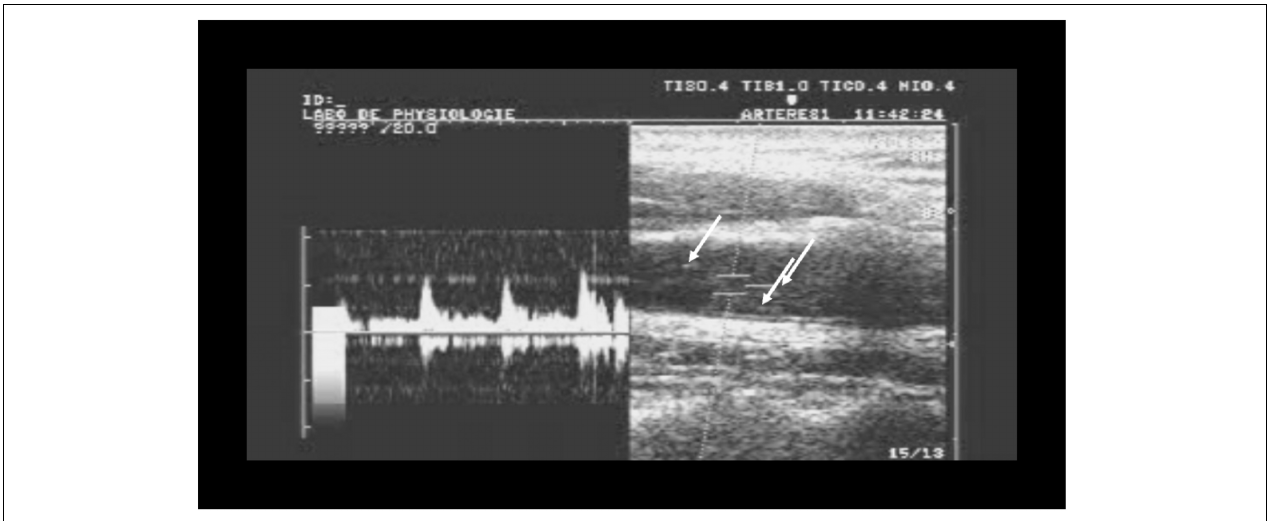
FIGURE 1 | Simultaneous Pulsed Wave Doppler-mode and B-mode ultrasound over the carotid artery, showing bubbles (arrows) passing through the imaging field producing the “gurgling” sound heard over the carotid artery with Doppler.